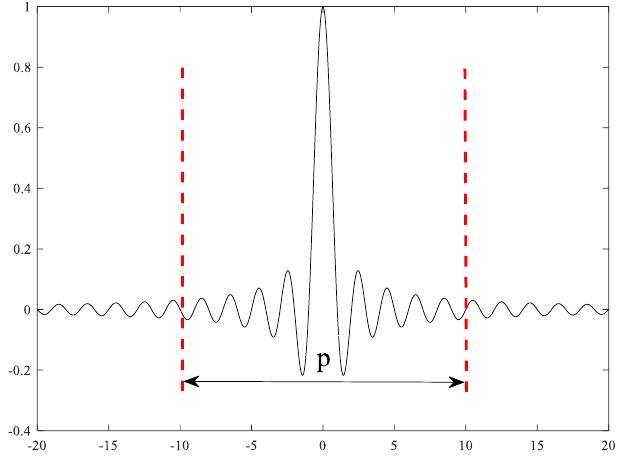
Figure 2. The parameter diagram P (main lobe ratio) of s i n C